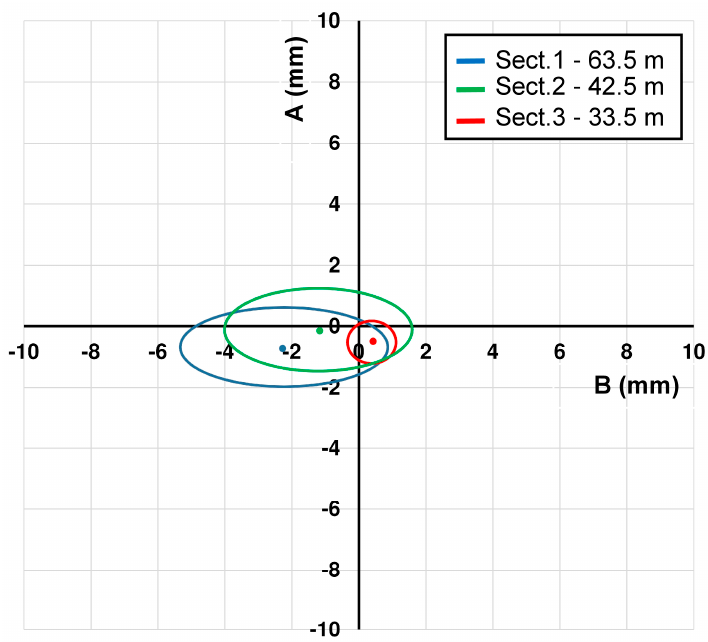
Figure 12. Ellipses of cumulative displacements on the top of the borehole for the three-inclinometer